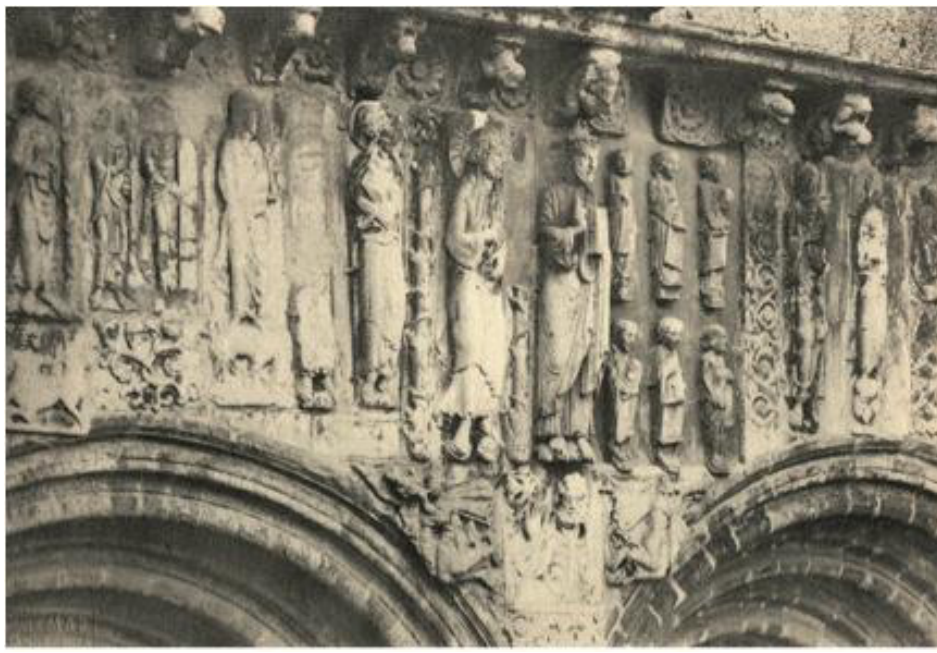
Roselló Mas, Puerta de las Platerías, upper portion. Apostles, St. James, Christ, God the Father, Apostles , from Arthur Kingsley Porter, Romanesque Sculpture of the Pilgrimage Roads , vol. 6, Castile, Asturias, Galicia (Boston: Marshall Jones Company, 1923), plate 676 (photo: author).